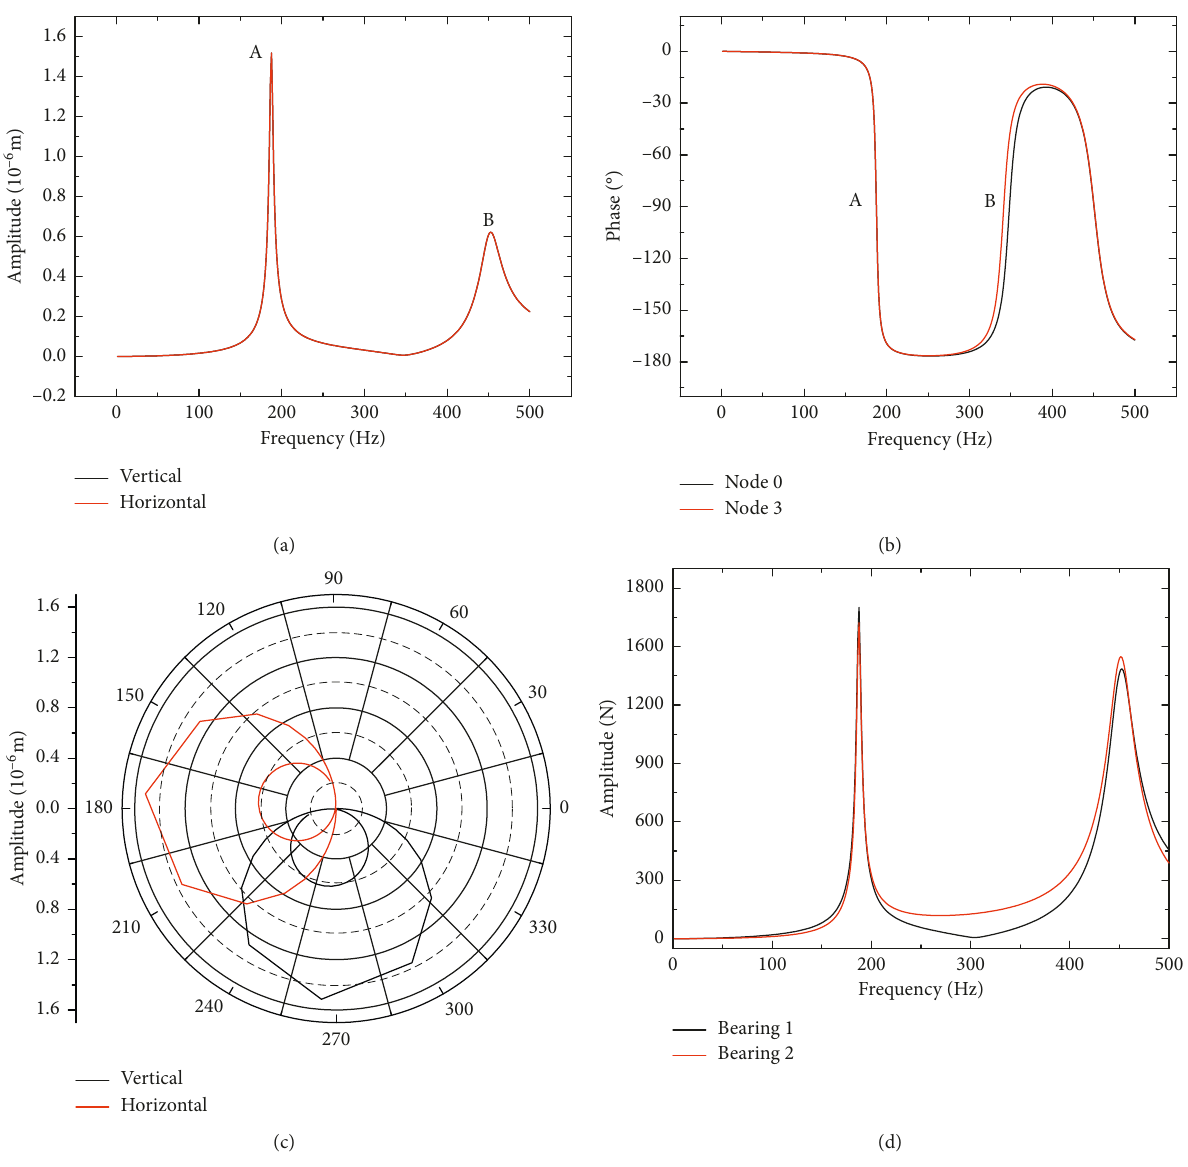
Figure 12: Rotor response and support reaction characteristics for condition 3 (isotropic bearing stiffness). (a) Amplitude response at node 0. (b) Phase response for vertical direction. (c) Polar diagram at node 0. (d) Support reaction at vertical